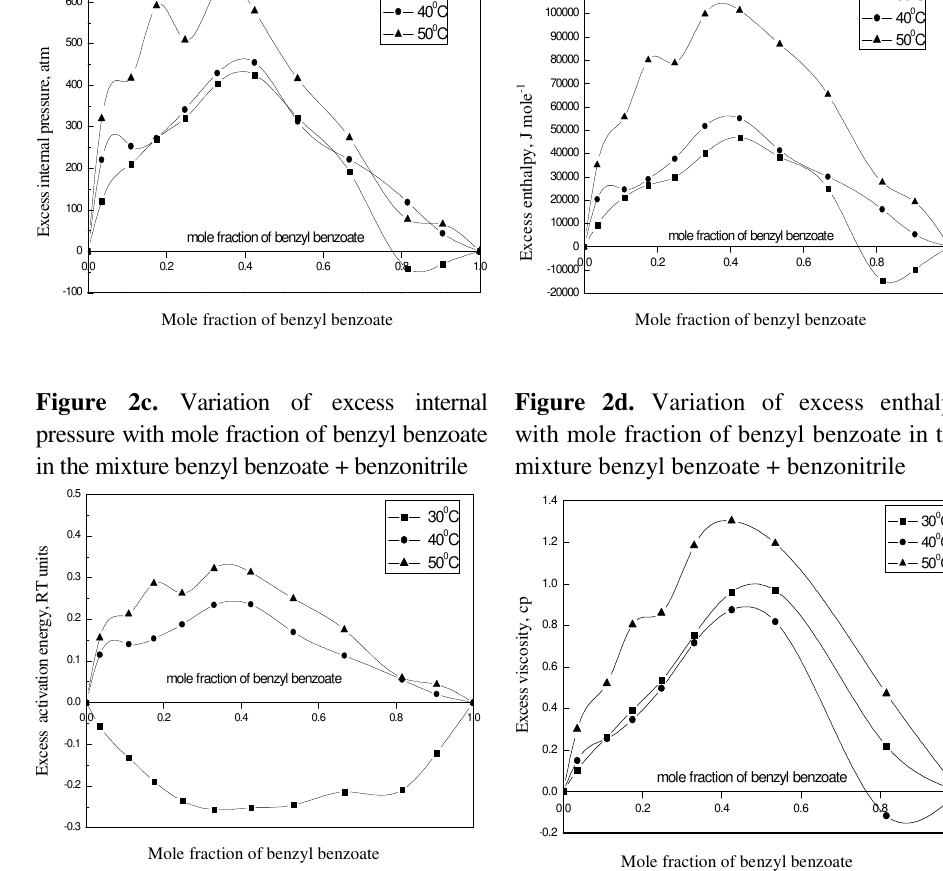
Figure 2e. Variation of excess activation Figure 2f. Variation of excess viscosity with energy with mole fraction of benzyl benzoate mole fraction of benzyl benzoate in the in the mixture benzyl benzoate + benzonitrile mixture benzyl benzoate + benzonitrile Though L fE and β E indicate strong AB interactions, the positive values of π E and H E indicate weak interactions and dispersive forces at concentrations below 0.90 m while afterwards i.e., at high concentrations strong AB interactions are indicated at 30 0 C. At 40 and 50 0 C totally weak interactions and dispersive forces result. From the positive values of G E and η E mostly endothermic type of reaction is suggested in the mixture. Temperature variation shows the increase of the nature of reaction. The excess parameters are fitted to the Redlich - Kister type of 3 rd order polynomial and the coefficients are presented in Table